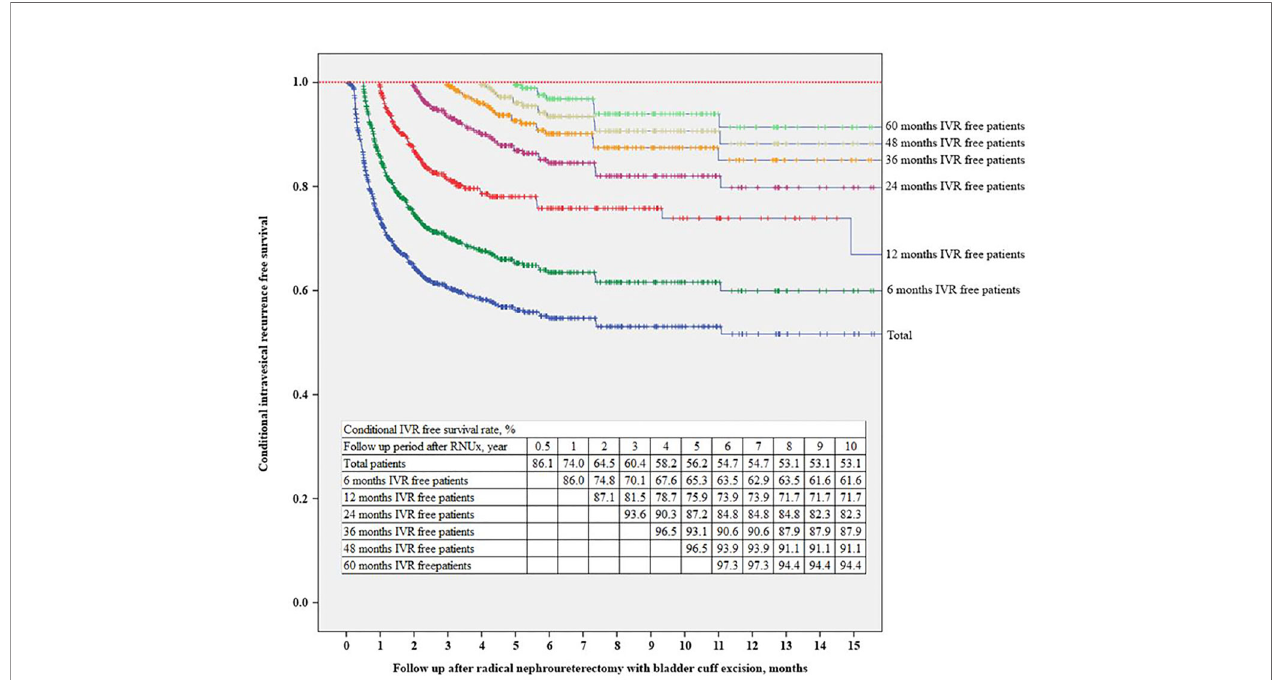
FIGURE 3 | Conditional intravesical recurrence-free survival. IVR, intravesical recurrence; RNUx, radical nephroureterectomy with bladder cuff excision.